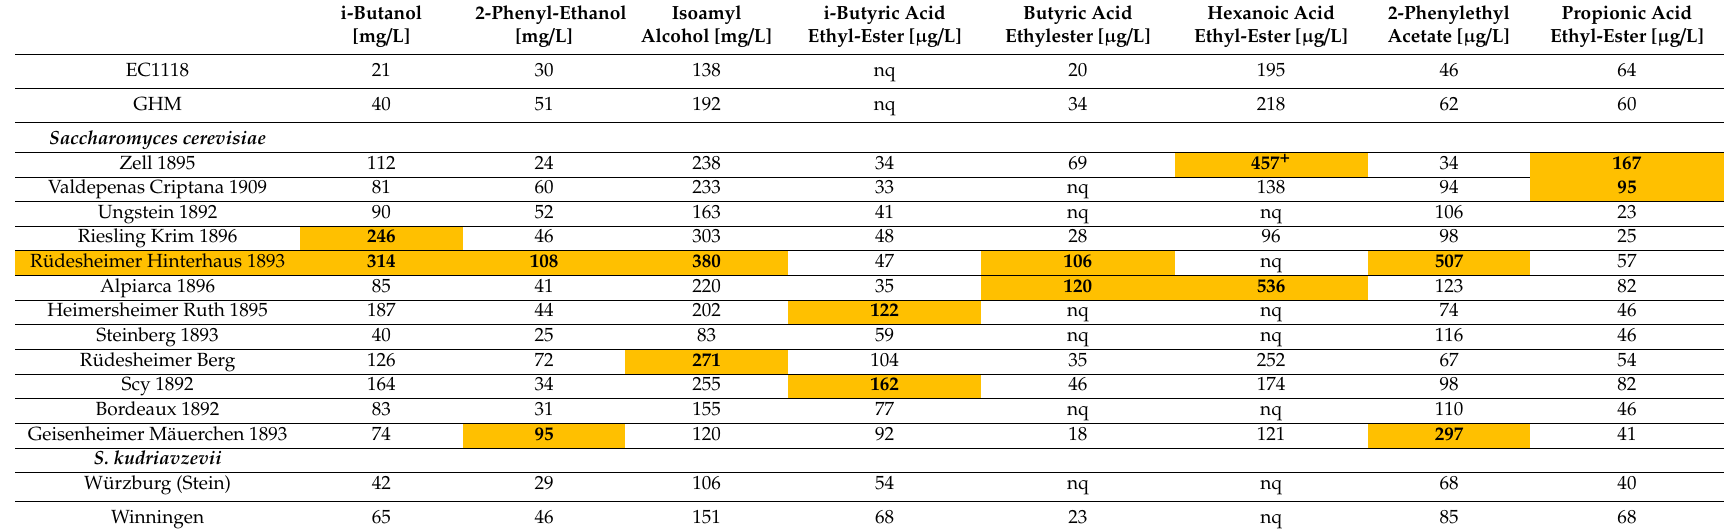
Table 3. Aroma compound generation determined at the end of